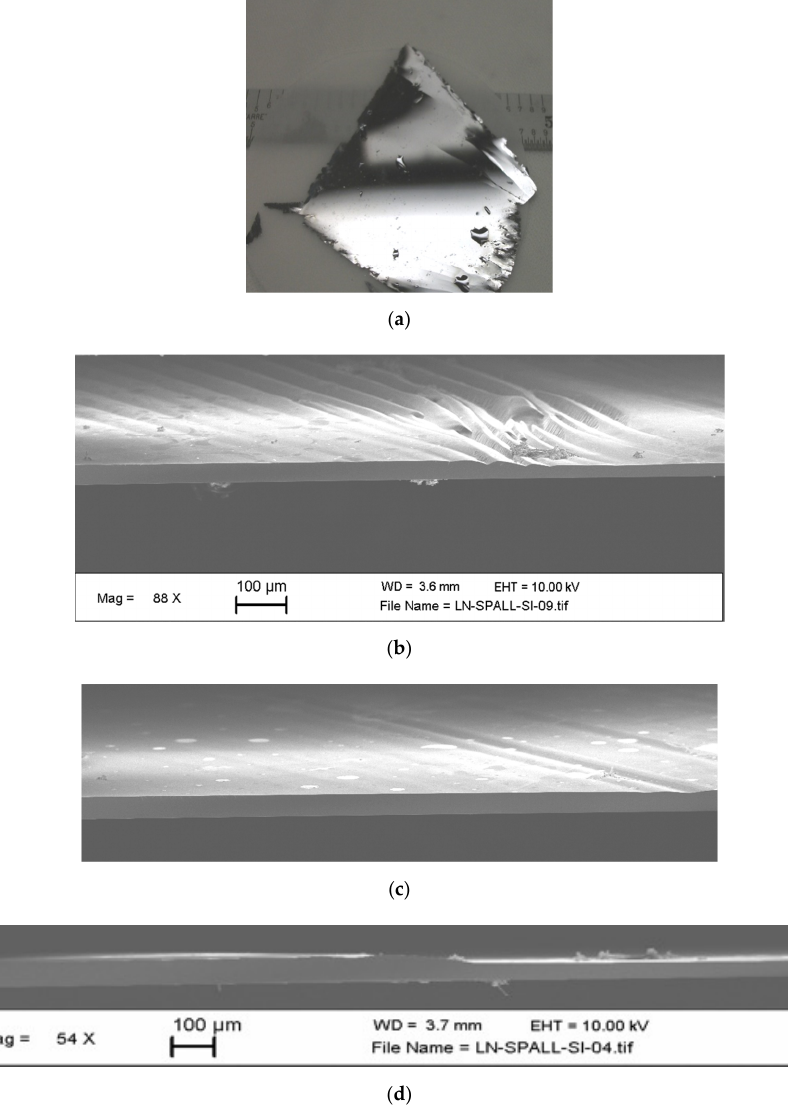
Figure 8. Cross-Section or side views of Si(100) spalled at 77 K. ( a ) Rough regions can be found. ( b ) Significant surface area is very smooth. ( c ) Spall material has thickness of 40–85 µm. ( d ) A broad area of the spalled layer of a length more than 1 mm shows the even spalled surface.